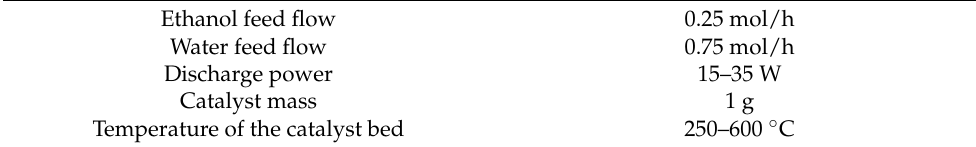
Table 1. Parameters of